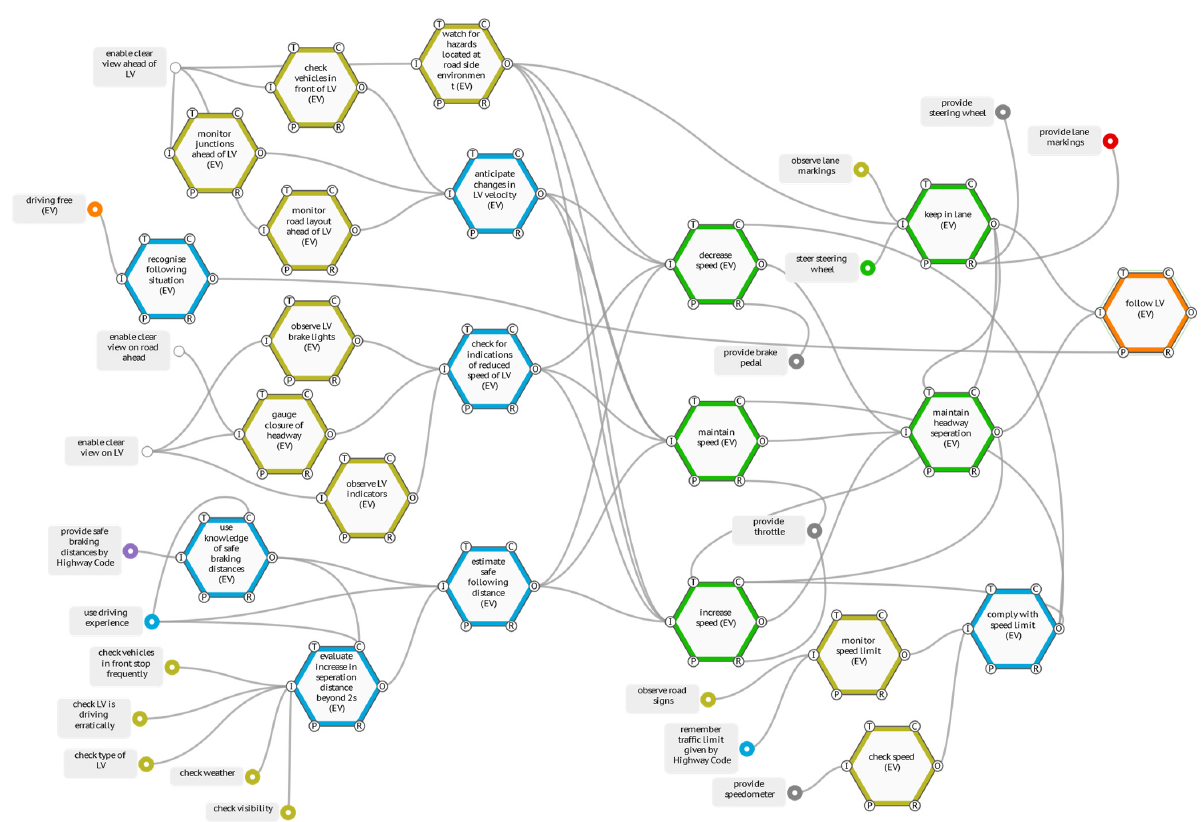
Figure A1. Illustration of the following process of EV in the Follow stage of the overall FRAM model.